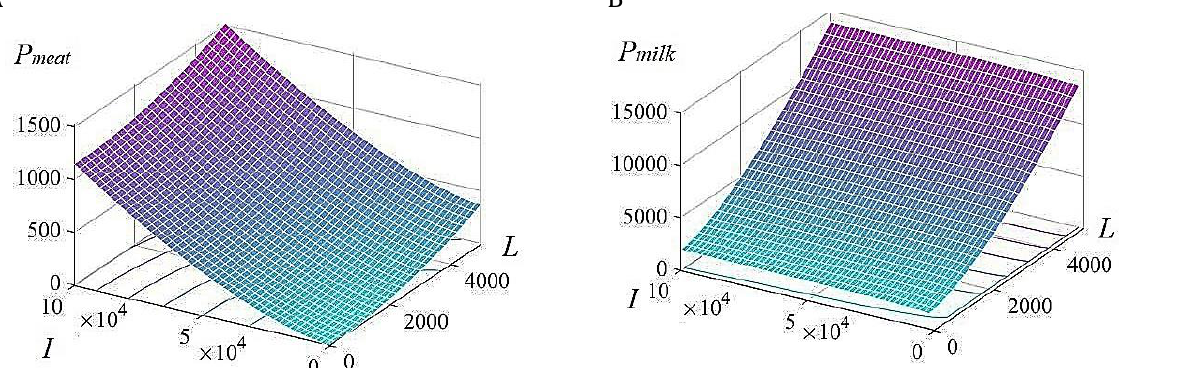
Fig. 5. Output volumes of organic A) meat and B) milk in relation to the number of cattle and capital investment in livestock